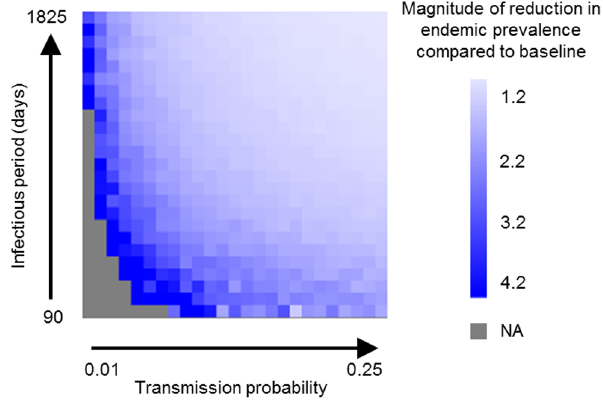
Figure 4. Effects of altering the transmission probability and infectious period half-life on simulation model results. The values shown are the predicted endemic prevalence when all replacement breeding cattle movements were removed from the network divided by the predicted endemic prevalence when an equivalent number of movements (including all movement types) were removed from the network at random. Grey squares indicate parameter combinations where disease was unable to persist on the network.